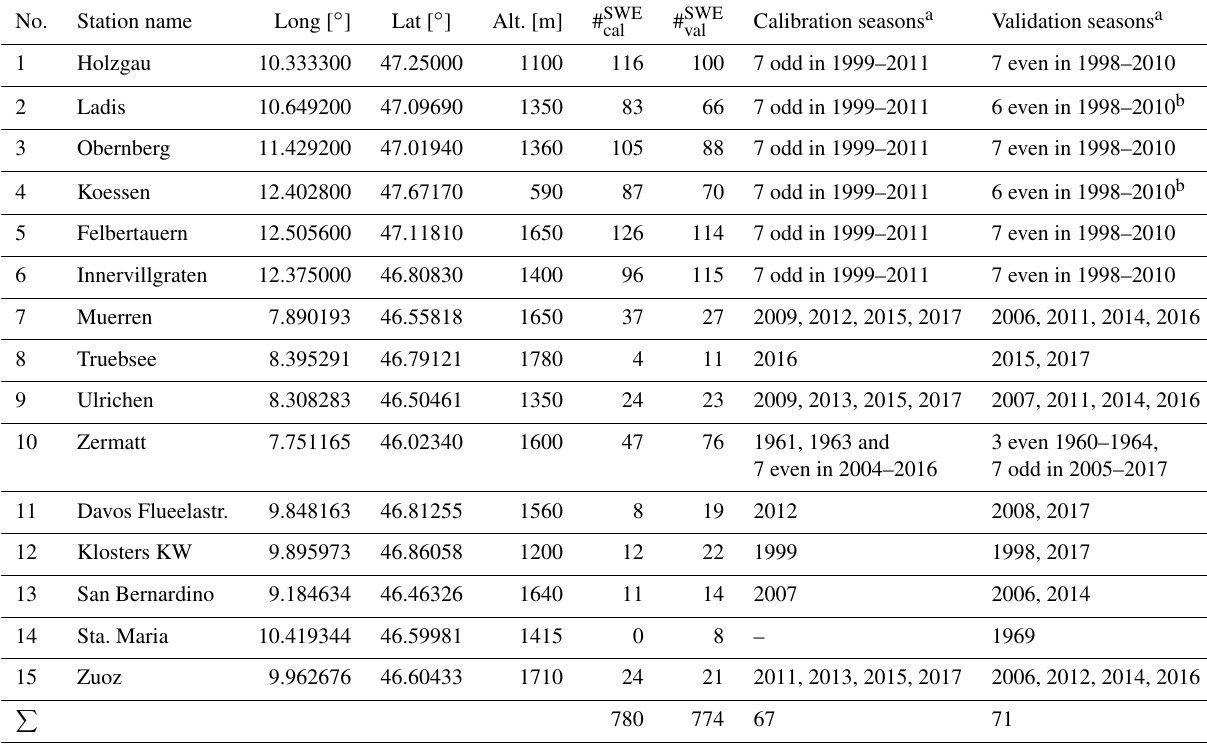
a Indicated years mark the start of respective winter seasons. b 2006 is